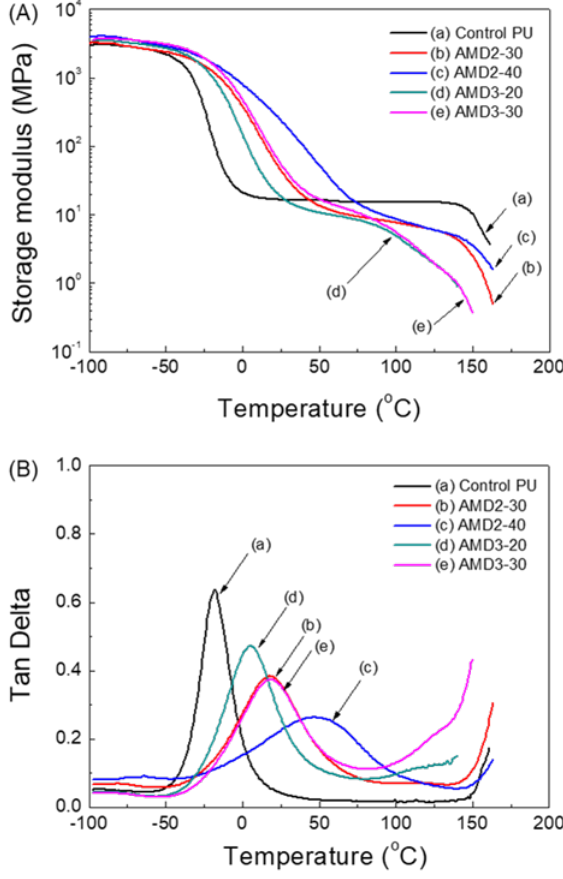
Figure 4. DMA thermograms of AMD-based PUs: ( A ) storage moduli of prepared AMD-based PUs; and ( B ) tan delta of prepared AMD-based PUs.